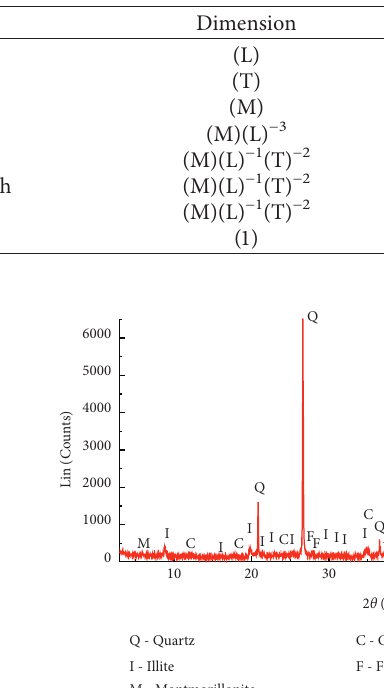
Table 1: Dimensional analysis.